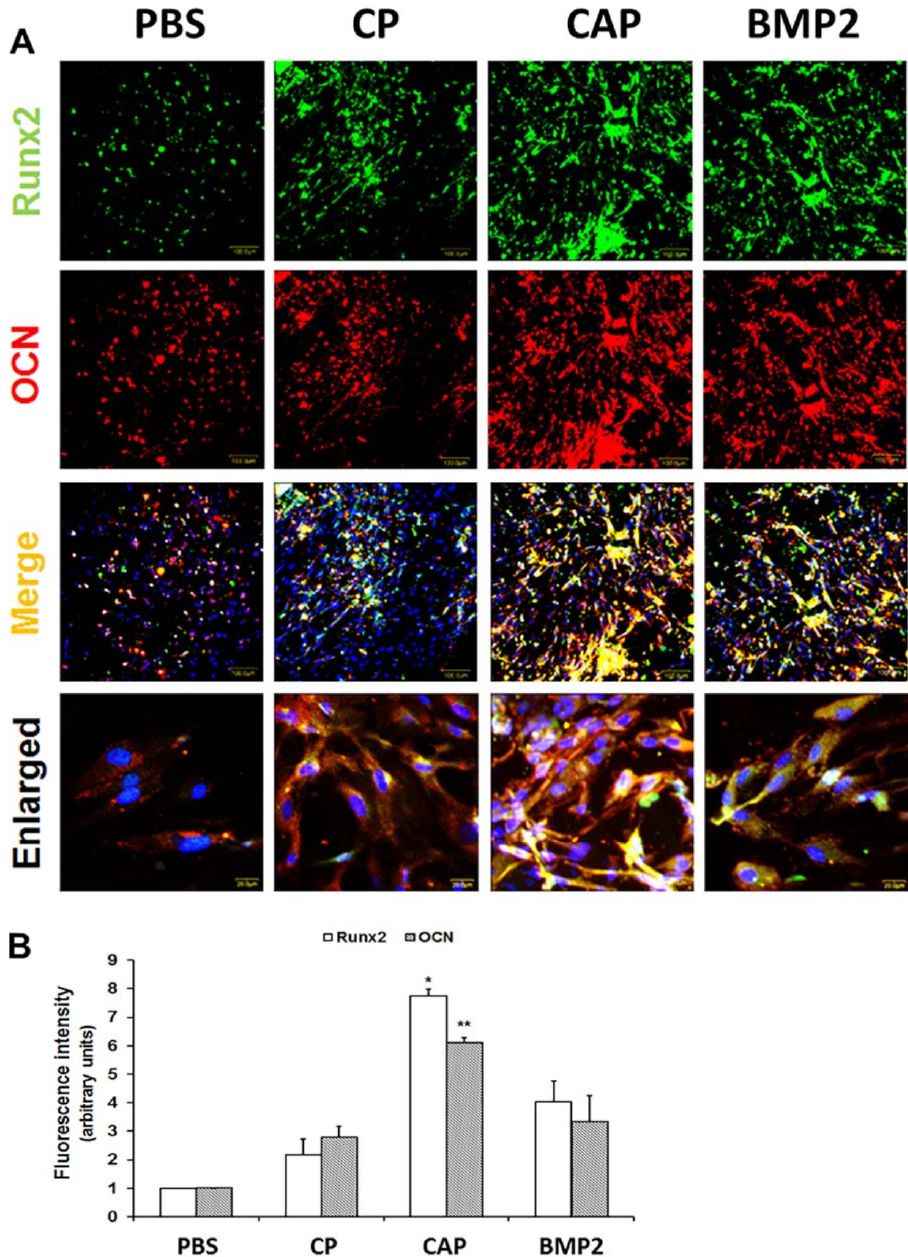
Figure 7. Expression of Runt-related transcription factor 2 (Runx2) and osteocalcin (OCN) in human PDLSCs (hPDLSCs) cultured in osteogenic medium (OM) for 14 days. ( A ): The hPDLSCs were cultured in hydrogels with calcium-accumulating peptide (CAP), control peptide (CP), or bone morphogenetic protein-2 (BMP-2) in four-well chambers and stained with respective antibodies. ( B ): (* p < 0.05, ** p < 0.05). Reproduced with permission from [85]. Copyright 2018 Wiley.